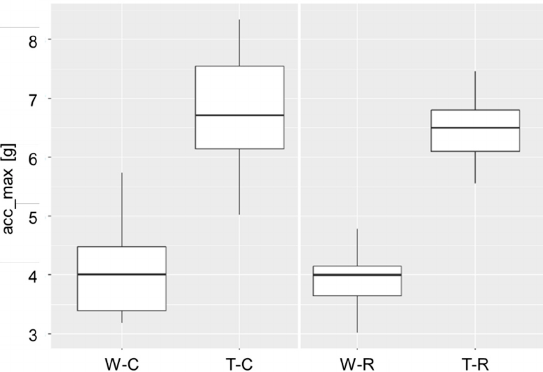
Figure 8. Influence of the factors gait (W = walk, T = trot) and flooring (R = rubber mats, C = concrete) on the peak acceleration acc_max at initial ground contact; mean values of 60 observations (mean values of automatically detected steps of the labeled gait sequences) from ten dairy cows are plotted. Furthermore, the other parameters were not influenced by the factors floor (C or R) or side (HL or HR). Except for the parameter gyr_z, the left hind limb was associated with higher values ( p = 0.003), compared to the right hind limb.